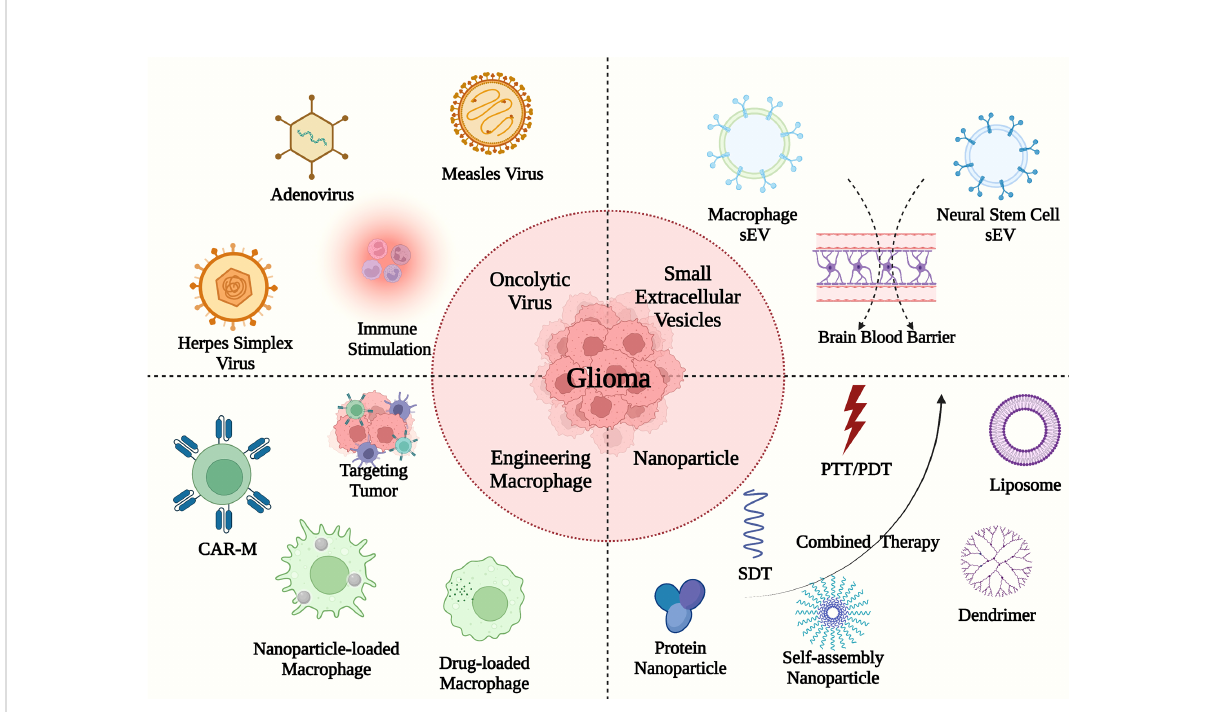
FIGURE 3 The TAM-targeting immune translational studies in GBM. The deliveries consist of oncolytic virus (e.g., herpes simplex virus, measles virus, and adenovirus), sEVs (e.g., macrophage sEV and neural stem cell sEV), engineering macrophages and nanoparticles with PTT/PDT/SDT (e.g., liposome, dendrimer, protein nanoparticle, and self-assembly